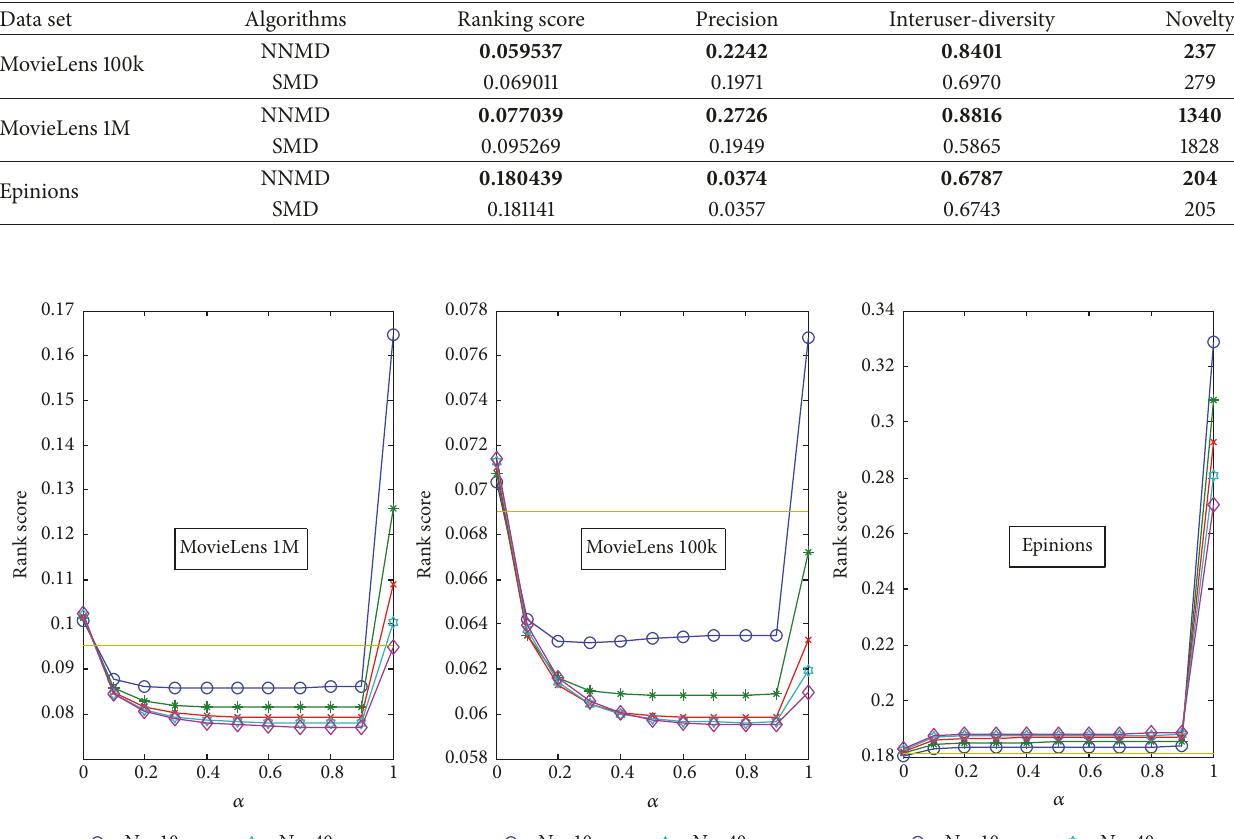
Table 3: Algorithmic performance for MovieLens 100k, MovieLens 1M, and Epinions data. The precision, interuser-diversity, and novelty are corresponding to 𝐿 = 20. The parameters for NNMD are 𝑁 = 50 and 𝛼 = 0.9 in MovieLens 100k and MovieLens 1M, while, in Epinions, the parameters are 𝑁 = 10 and 𝛼 = 0. The entries corresponding to the best performance over all methods are emphasized in bold.